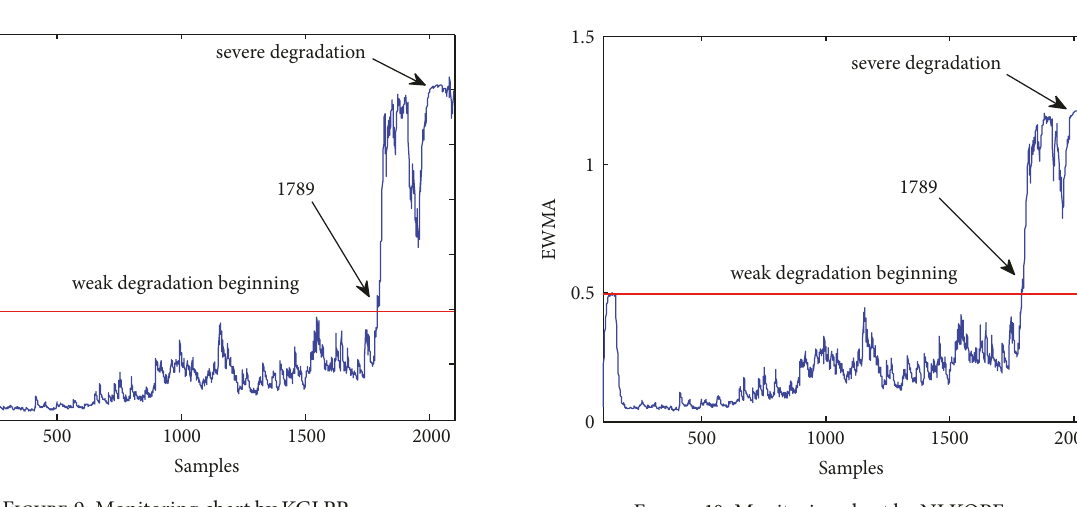
Figure 9: Monitoring chart by KGLPP. Figure 10: Monitoring chart by